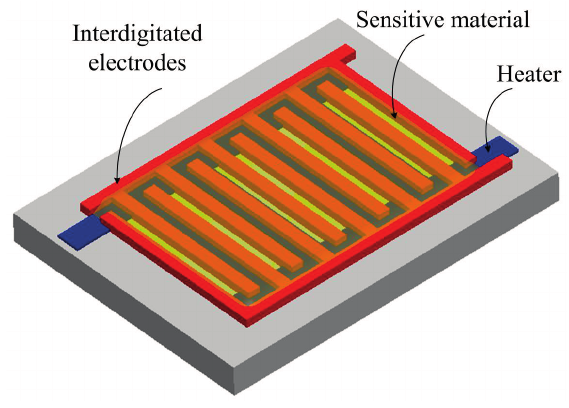
Figure 1. Schematic structure of the acetone